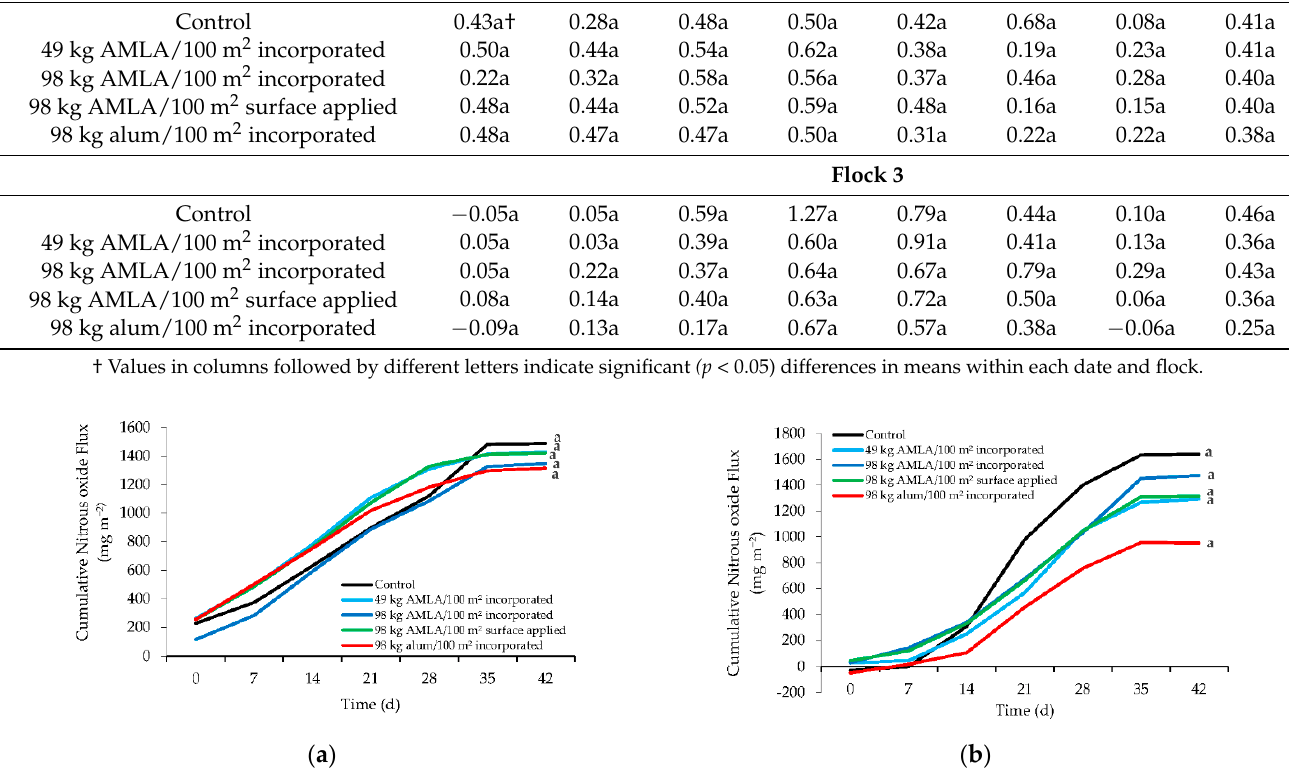
Figure 1. Cumulative nitrous oxide flux (mg N 2 O-N m − 2 ) for ( a ) flock 2 and ( b ) flock 3 as a function of time. Treatments on day 42 not sharing a common letter are significantly different ( p < 0.05).